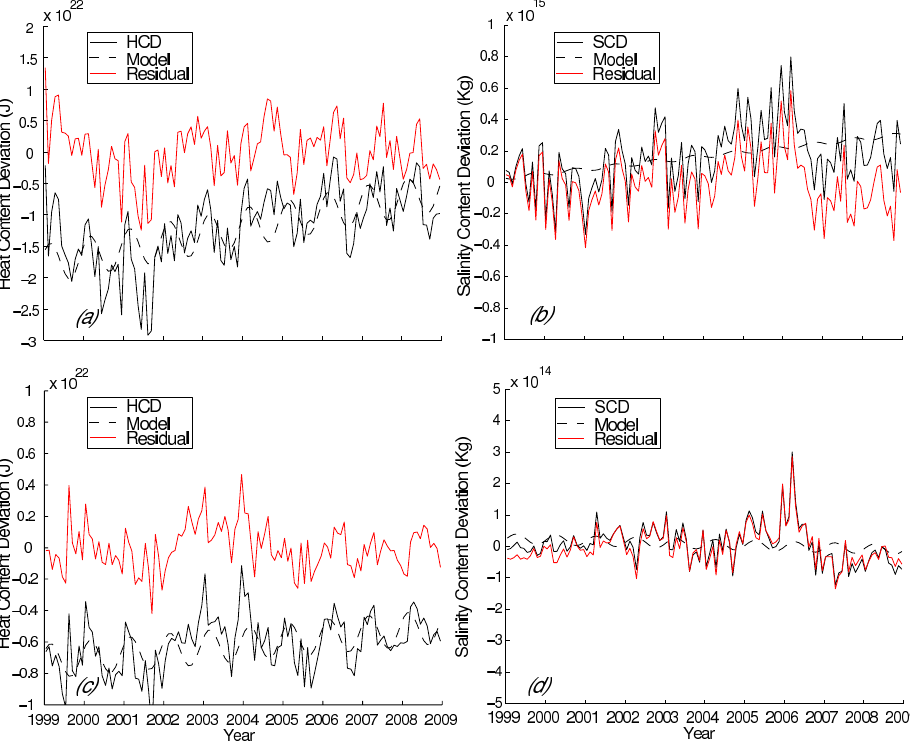
Fig. 6. Heat and salinity contents deviations, LTPO model and residual part: (a) HCD for the whole basin between 0 and 2000m; (b) – SCD for the whole basin between 0 and 2000m; (c) – HCD for the belt between 20 ◦ N and 30 ◦ N between 0 and 2000m; (d) – SCD for the belt between 20 ◦ N and 30 ◦ N between 0 and